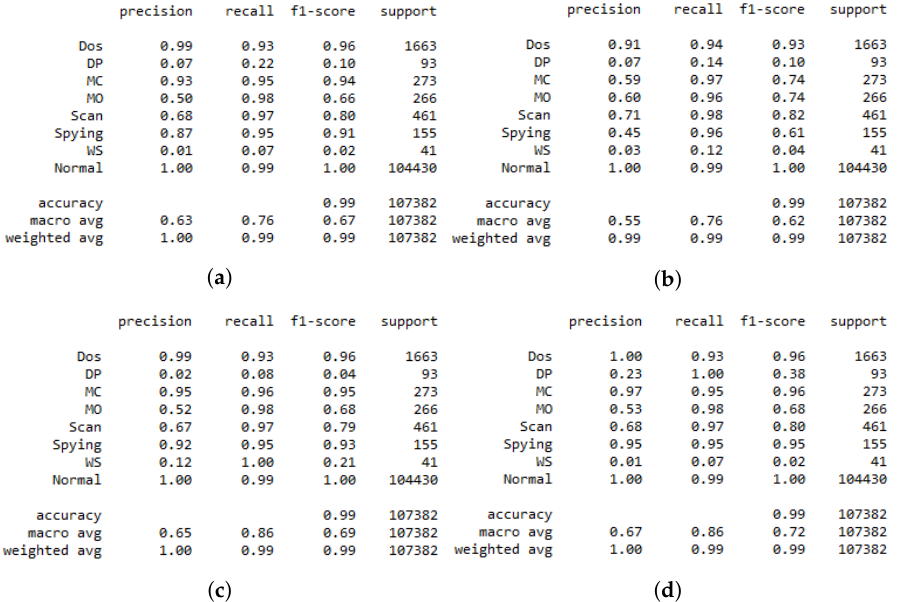
Figure 6. Multiclass classification report. ( a ) Normal DRL. ( b ) DRL with GAN 1 . ( c ) DRL with GAN 2 . ( d ) DRL with GAN 3 .